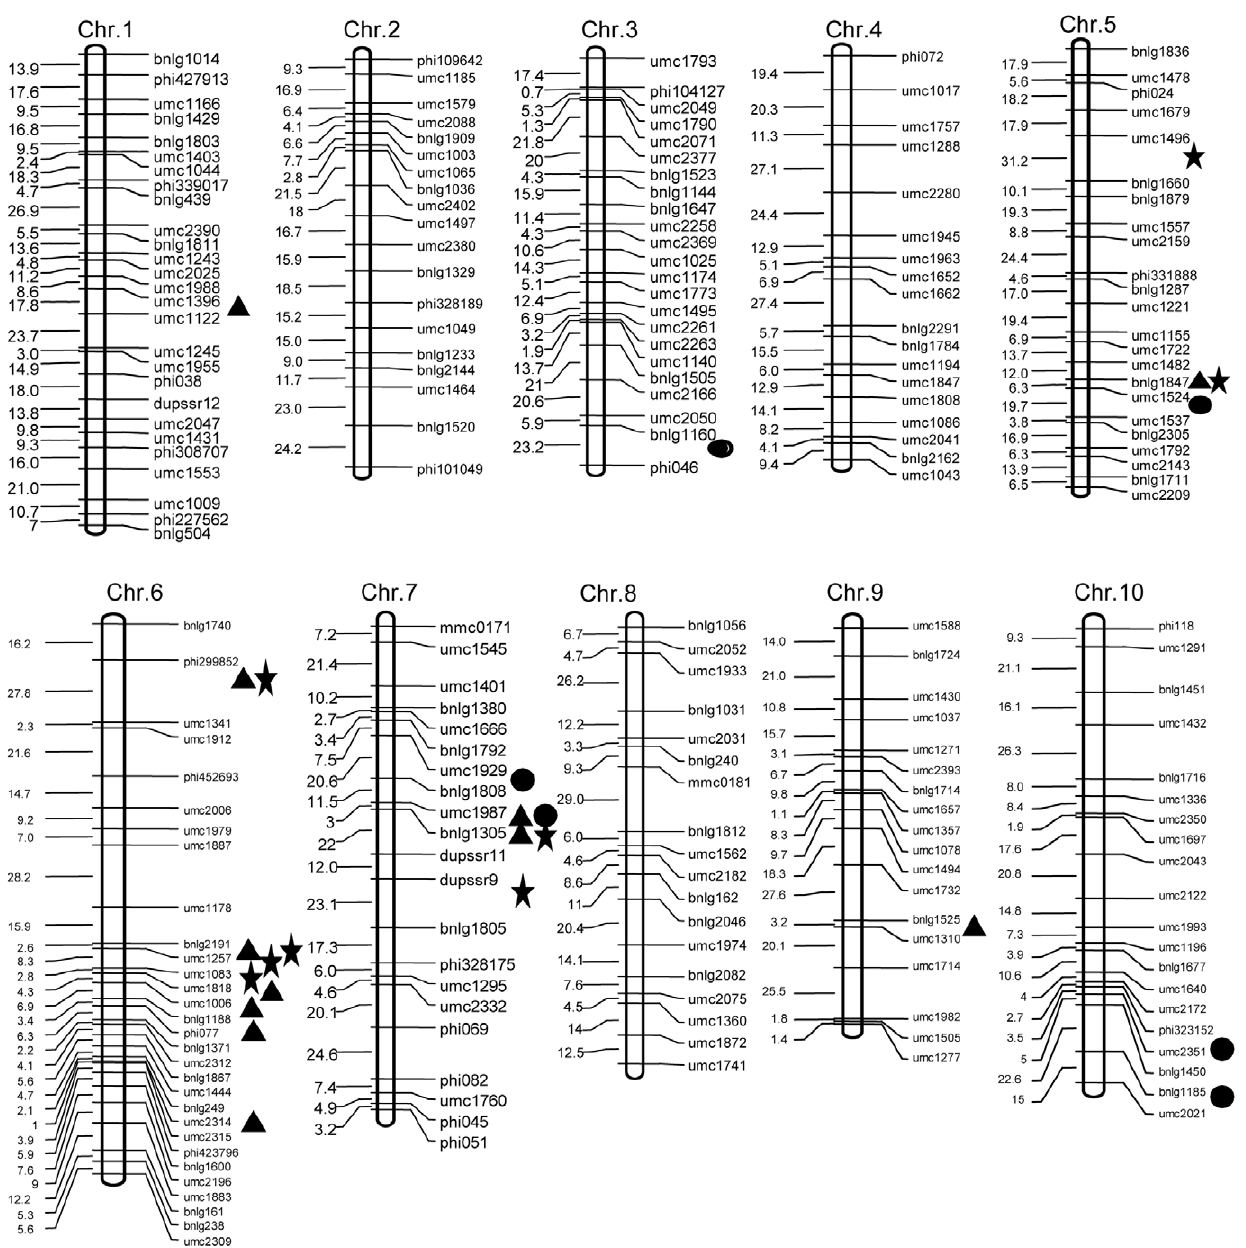
Figure 3. Chromosomal locations of QTLs detected for grain filling rate and kernel weight. Note: Triangle unconditional QTLs detected for grain filling rate, Star conditional QTLs detected for grain filling rate, Round unconditional QTLs detected for kernel weight.